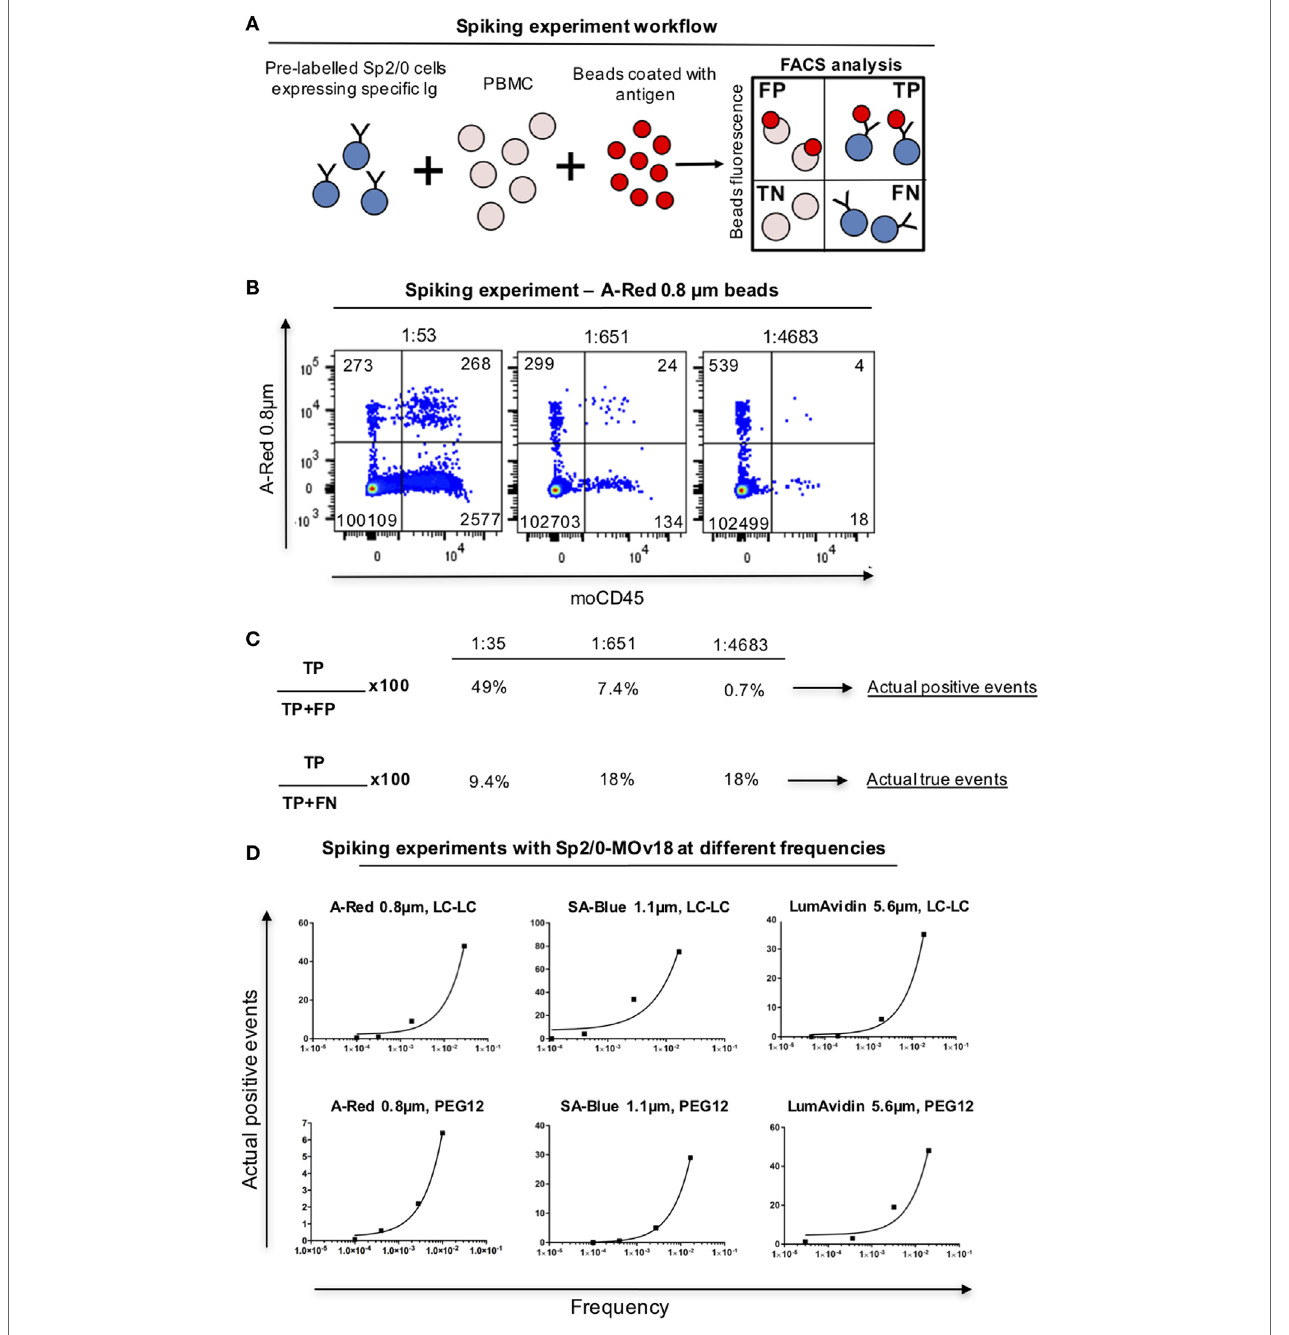
FigUre 6 | Detection of antibody-expressing B cells in peripheral blood mononuclear cells (PBMC) samples using fluorescent beads. (a) Schematic representation of Sp2/0 “spiking” of PBMCs. Flow cytometric dot plots are separated in quadrants labeled as follows: FP, false positive; TP, true positive; TN, true negative; FN, false negative. (B) Flow cytometric analyses of A-Red 0.8 µm beads incubated with PBMC spiked with different numbers of Sp2/0-MOv18 cells pre-labeled with an anti-CD45 antibody. Actual dilutions are indicated above each dot plot. The actual dilution was calculated by dividing the number of live Far-red positive events (antigen specific cells) by the number of live Far-red negative events (PBMC). Numbers in each quadrant indicate the absolute number of cells detected. (c) Calculation of Actual positive events and Actual true events from data obtained with “spiking” of PBMCs. Actual positive events and Actual true events for each frequency tested in B were calculated using the formulas on the left. (D) FR α+ beads of different sizes recognize Sp2/0-MOv18 B cells found at different frequencies in PBMCs. Actual positive events out of all bead-bound events were analyzed and demonstrate correlation between cell frequency and percentage of Actual positive events. A-Red 0.8 µm beads (left); SA-Blue 1.1 µm beads (middle), and LumAvidin 5.6 µm beads (right). Top panels: LC-LC biotin coupling; bottom panels: PEG12 biotin